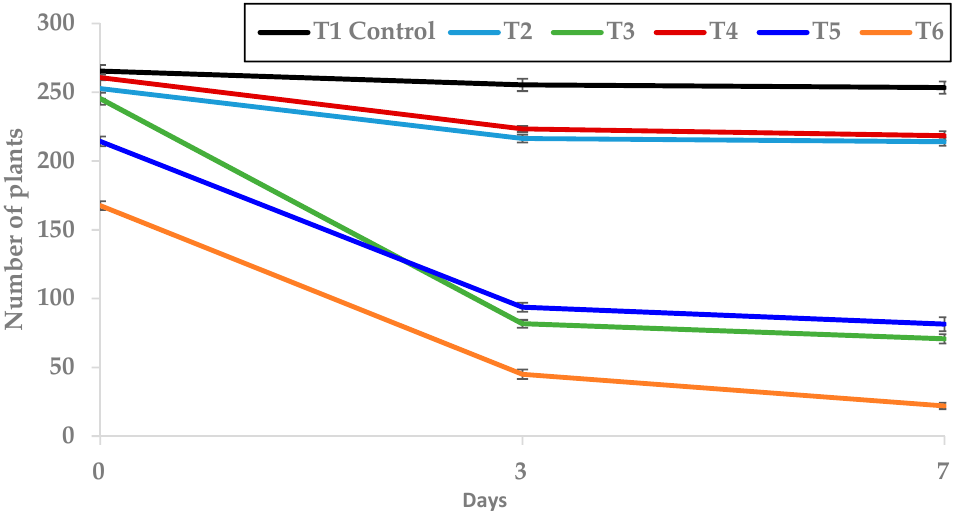
Figure 9. Effect of T1 to T6 treatments applied in post-emergence on the number of plants grown (mean ± standard error) in the trays where they were applied.